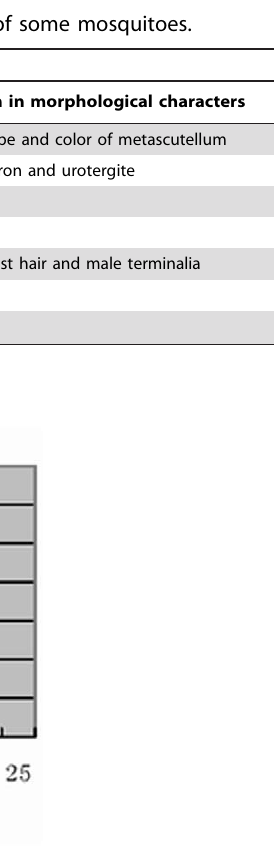
Figure 3. Two distinct sub-trees comprised of Anopheles and Culex in the NJ phylogenetic tree (Fig. 2).